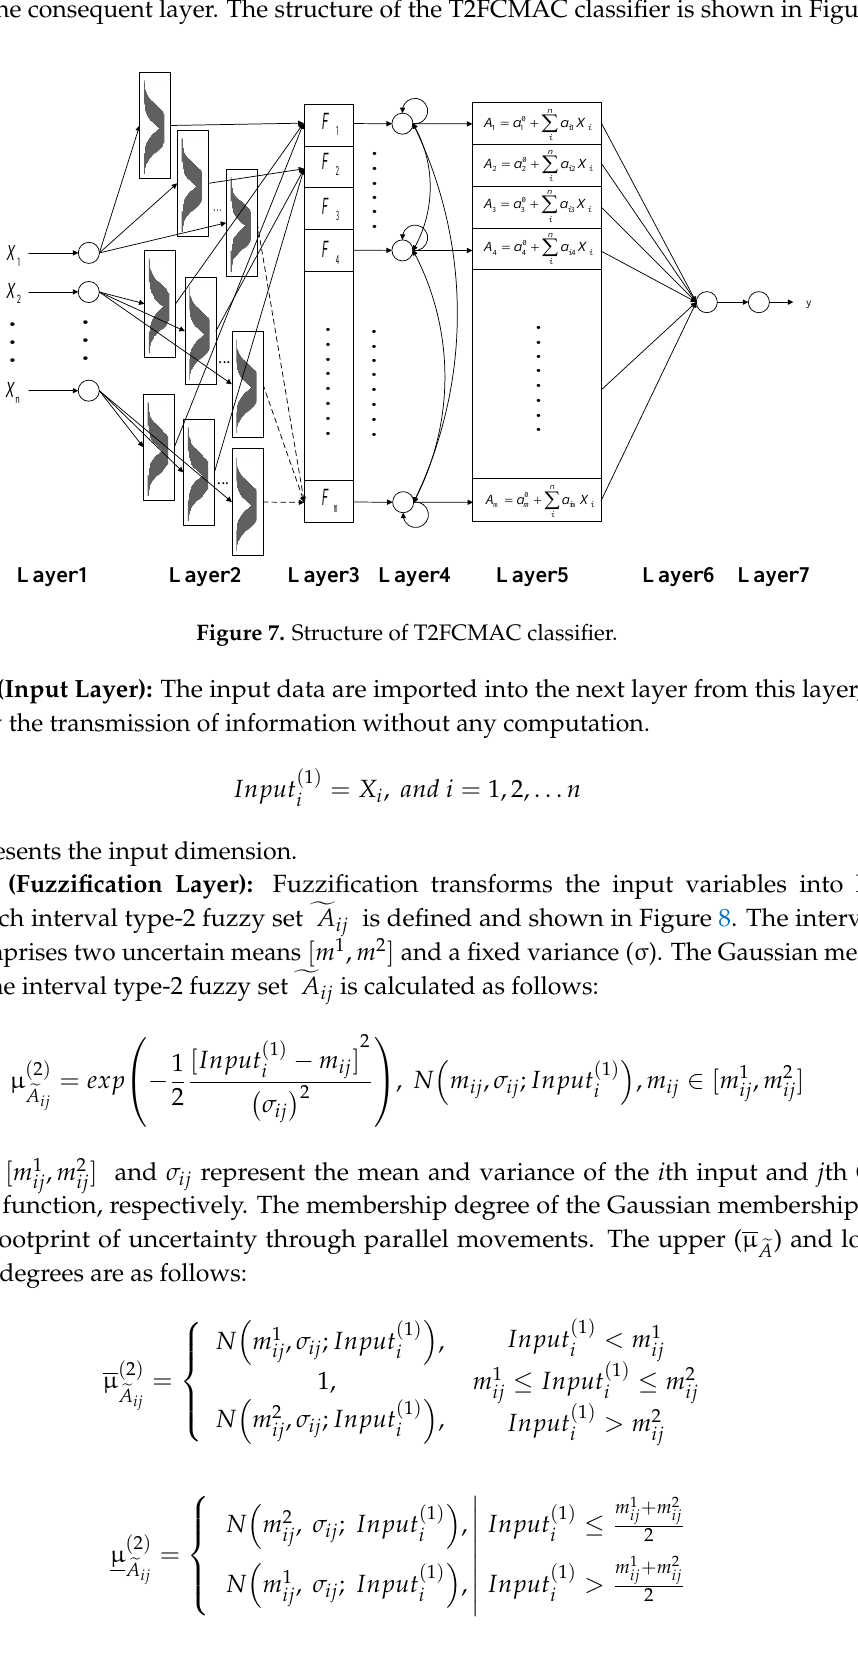
Figure 8. Interval type-2 fuzzy set.